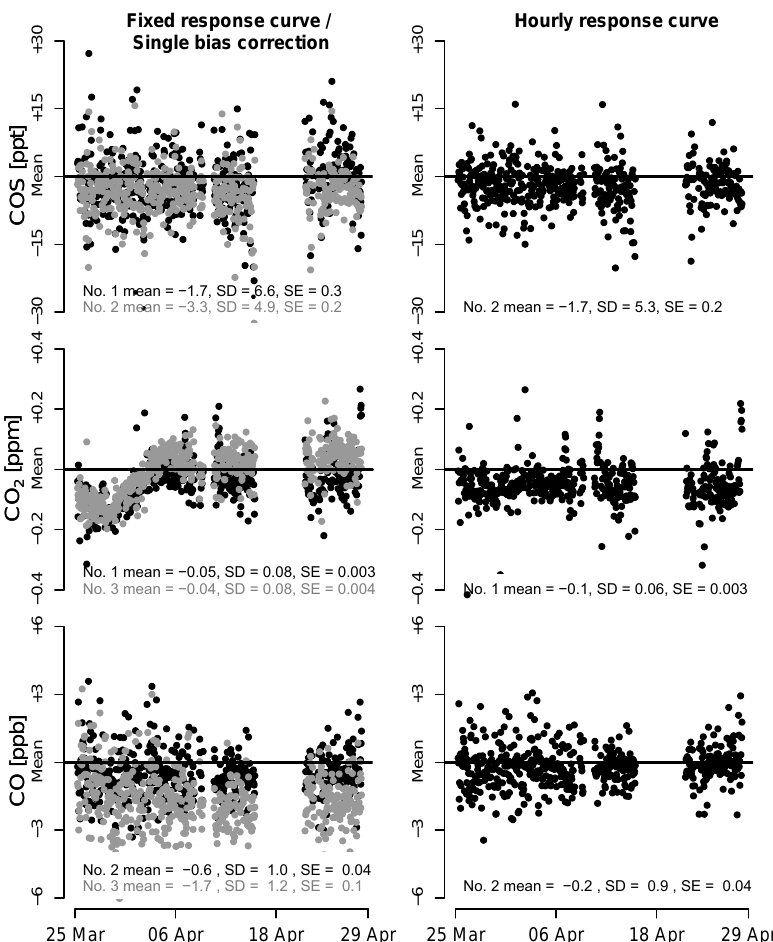
Figure 8. Mole fraction offsets in target standards after application of (left) corrections with a fixed response curve for CO 2 and CO that was determined in the laboratory (see Sect. 2.2.1) and with a single bias correction for COS, and (right) corrections with changing response curves determined from the hourly measurements of working standards. For the fixed response curve measurements of two target standards are shown, for the hourly response curve only one is shown, as two of the three working standards were needed to determine the response curve. The mean deviation from the assigned cylinder value, standard deviation (SD) and standard error (SE) are given for each target standard. The cylinder numbers (nos. 1, 2, 3) correspond with the cylinder numbers and assigned cylinders values given in Fig.